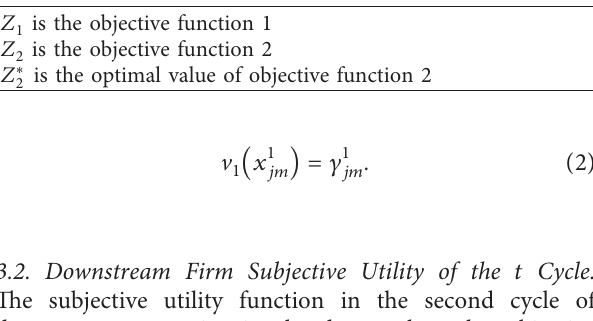
Table 4: Objective functions description of discrete supply